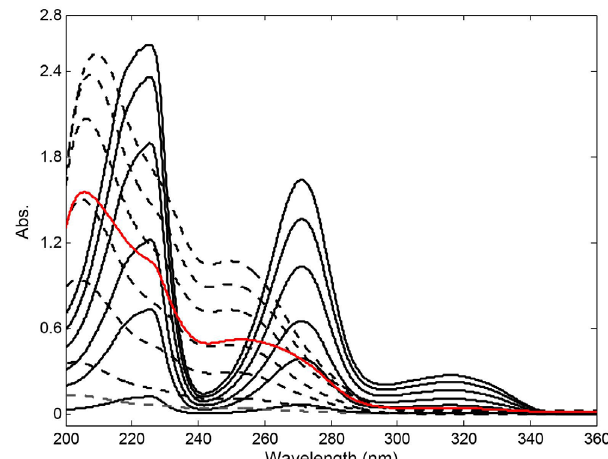
FIGURE 1 - The UV spectra of VAL (----) : 1.0, 3.0, 9.0, 15.0, 21.0, 27.0, 33.0 µ g/mL and HCT (  ) : 1.0, 6.0, 11.0, 16.0, 21.0, 26.0 µ g/mL and tablet sample (  ) containing 2.50 µ g/mL of VAL and 16.0 µ g/mL of HCT in pH 6.8 phosphate